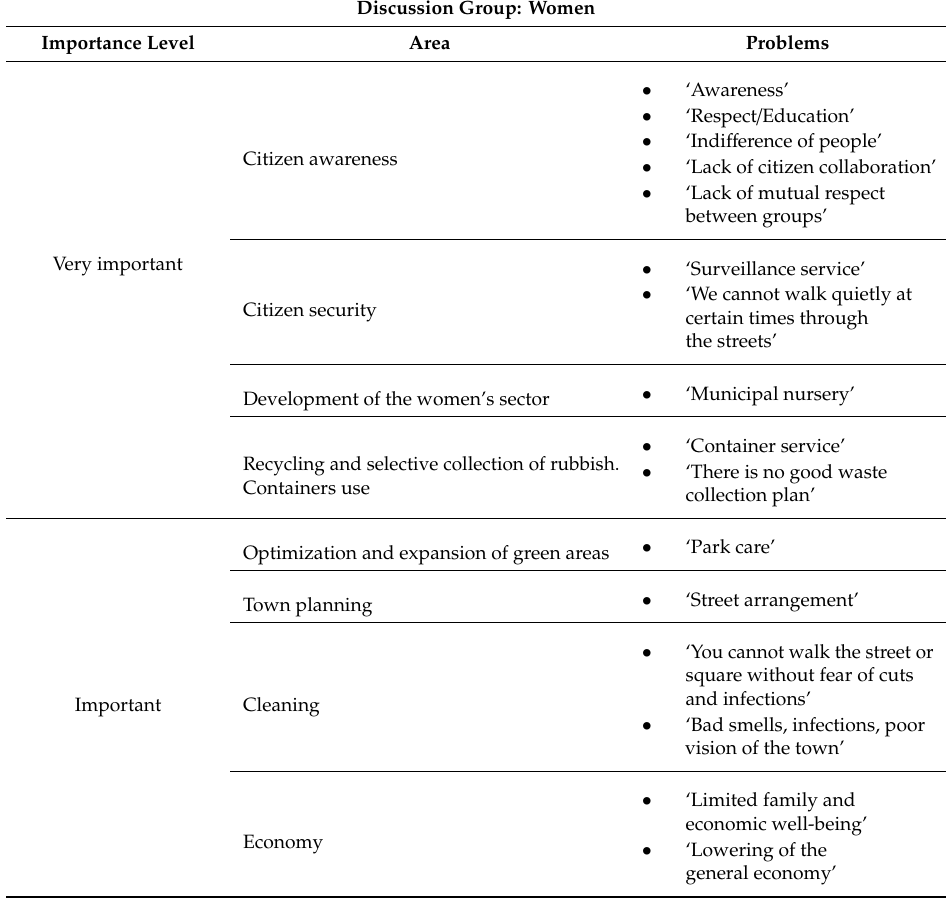
Table 11. Socio-environmental problems extracted from the discussion group ‘women’.